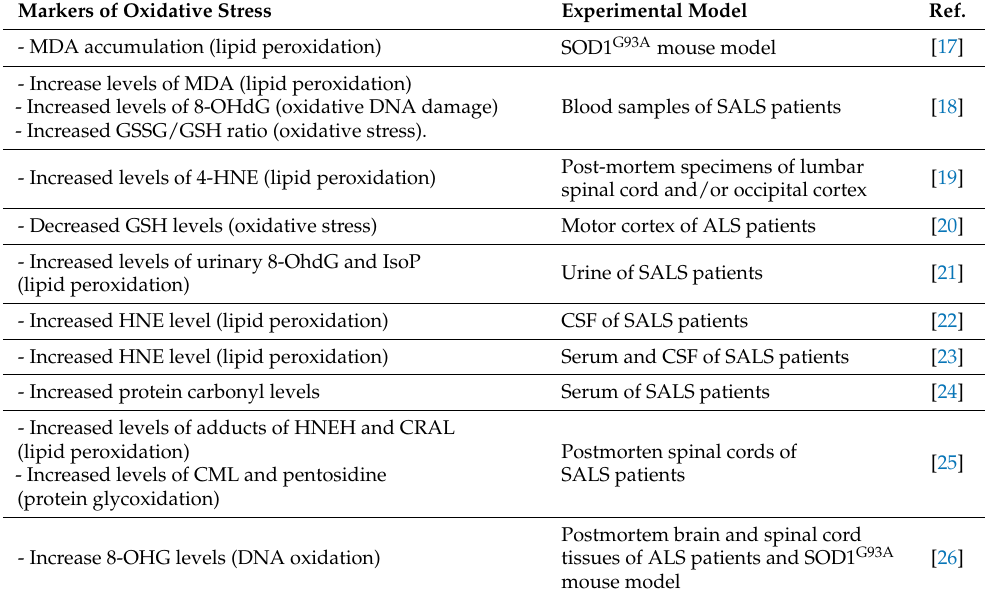
Table 1. Oxidative stress markers in ALS animal models and patients. Markers of Oxidative